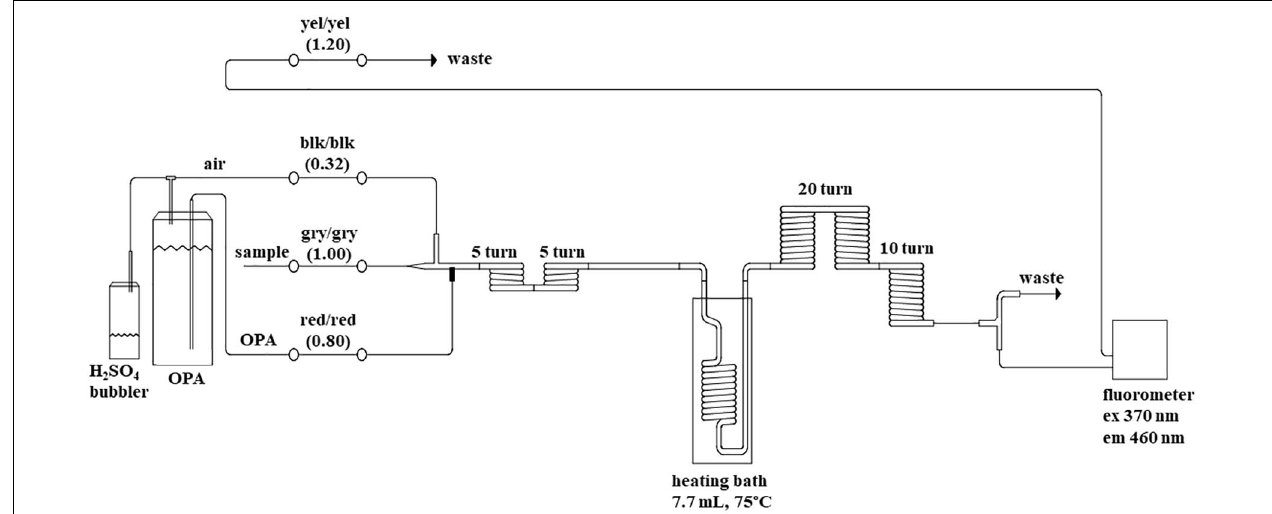
FIGURE 1 | Flow diagram of the segmented flow system for ammonium. Color codes for peristaltic pump tube flow rate (blk = black, yel = yellow, gry = gray) are in brackets (mL per minute). Details of reagent preparation are within the text. Ex = excitation wavelength and Em = emission wavelength. The internal diameter of the glass component is 2.0